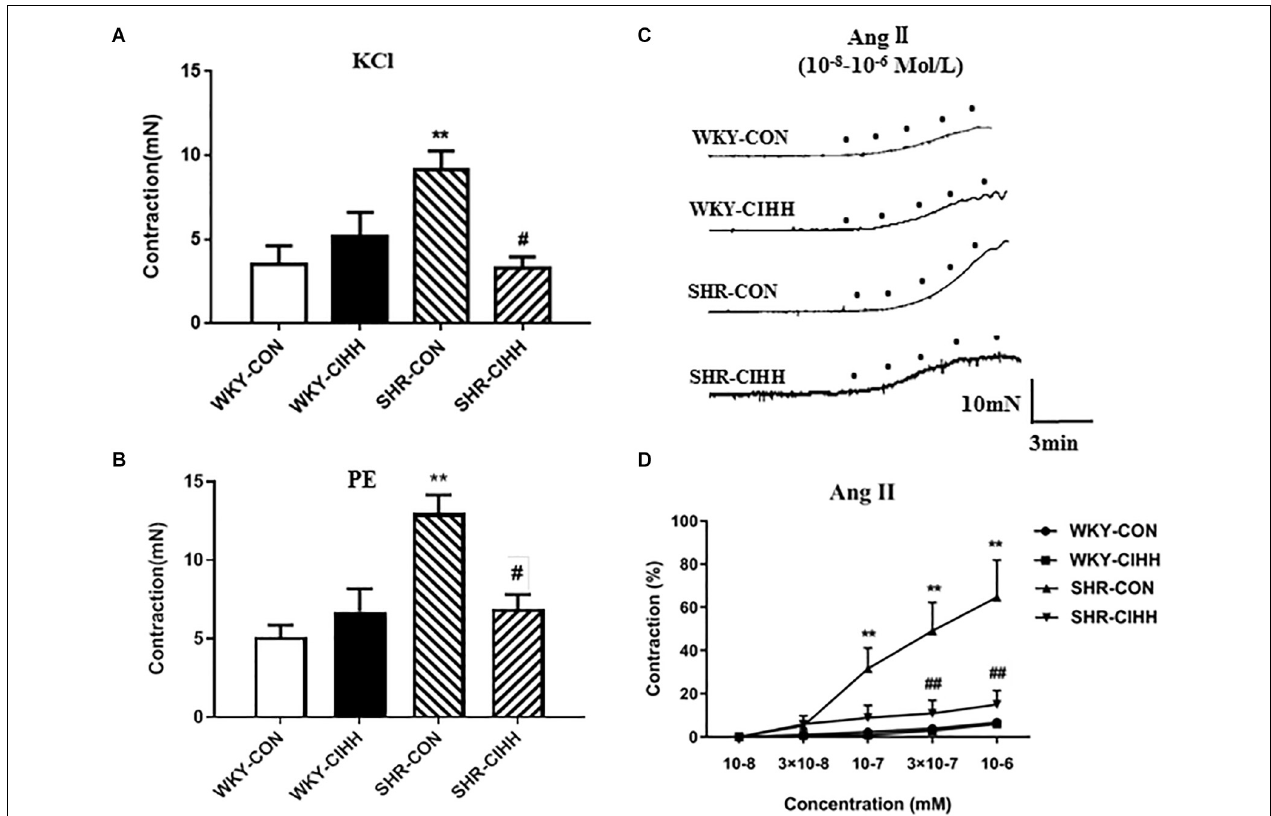
FIGURE 5 | Effect of chronic intermittent hypobaric hypoxia (CIHH) on PE-induced, KCl-induced, and Ang II-induced contraction of the mesenteric arteries from spontaneously hypertensive rats (SHRs). Summarized data of mesenteric arteries in response to KCl (A) and PE (B) . Representative contraction traces (C) and summarized data (D) of mesenteric arteries in response to different concentrations of Ang II. Data are expressed as mean ± SEM; SHR-CON: control SHR ( n = 14); SHR-CIHH: SHR with CIHH ( n = 12); WKY-CON: control WKY rats ( n = 12); WKY-CIHH: WKY rats with CIHH ( n = 12); ** P < 0.01 vs. WKY-CON, # P <